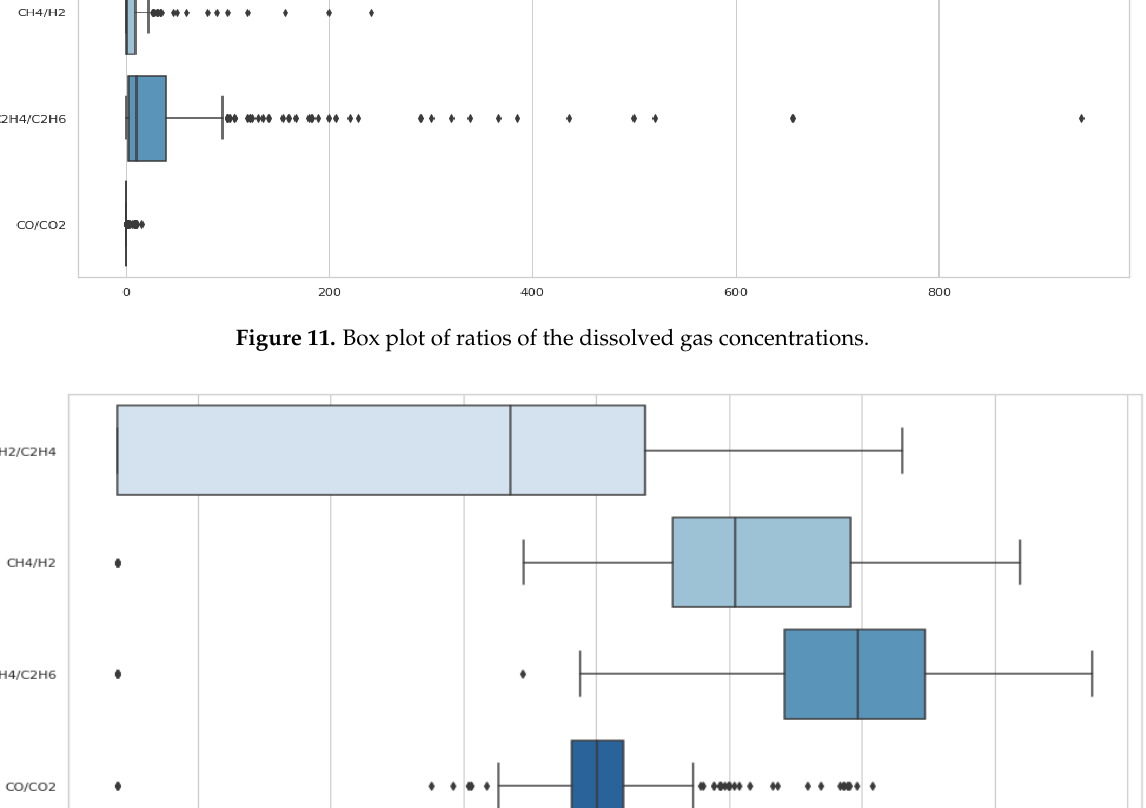
Figure 13. Spearman correlation coefficients in relation to the state of the power transformer.